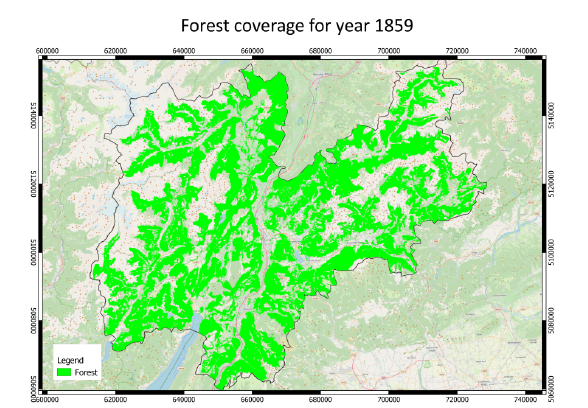
Figure 8. Forest coverage in the Trentino region in 1859.